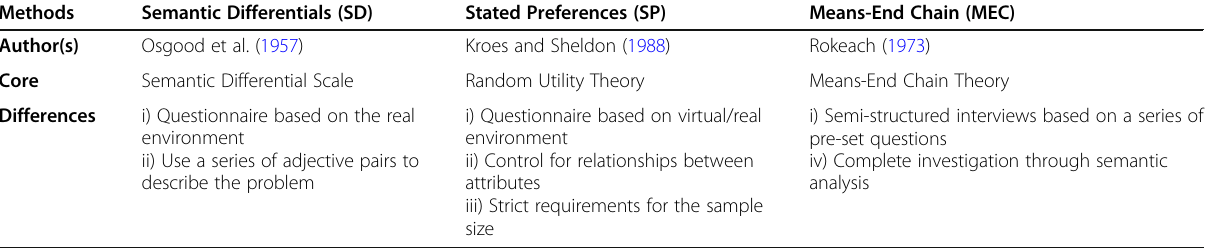
Table 2 Horizon comparison between preference measurement